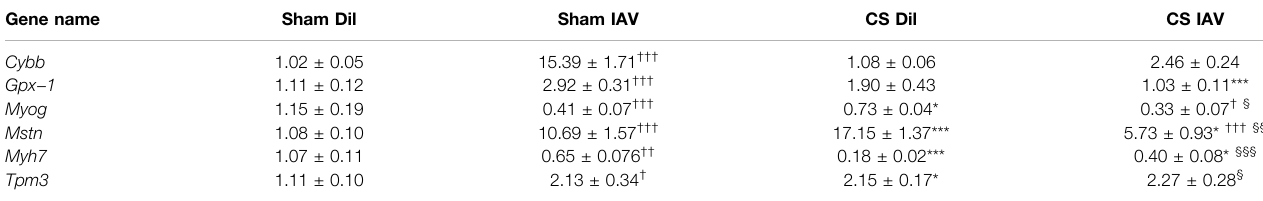
TABLE 1 | Summary of gene expression data from the TA muscle (mean ± SEM).